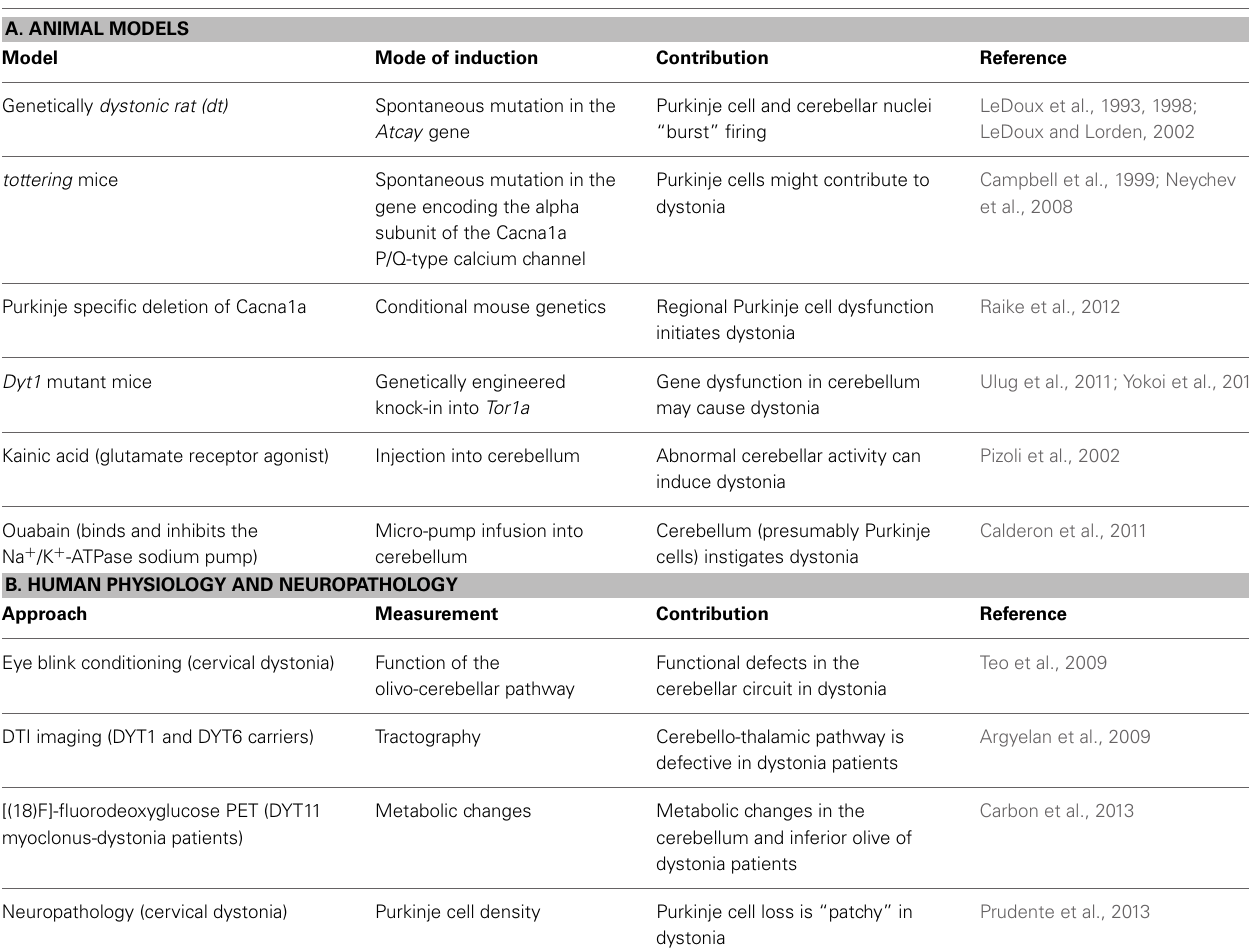
Table 2 | Animal models and human data that implicate the cerebellum in